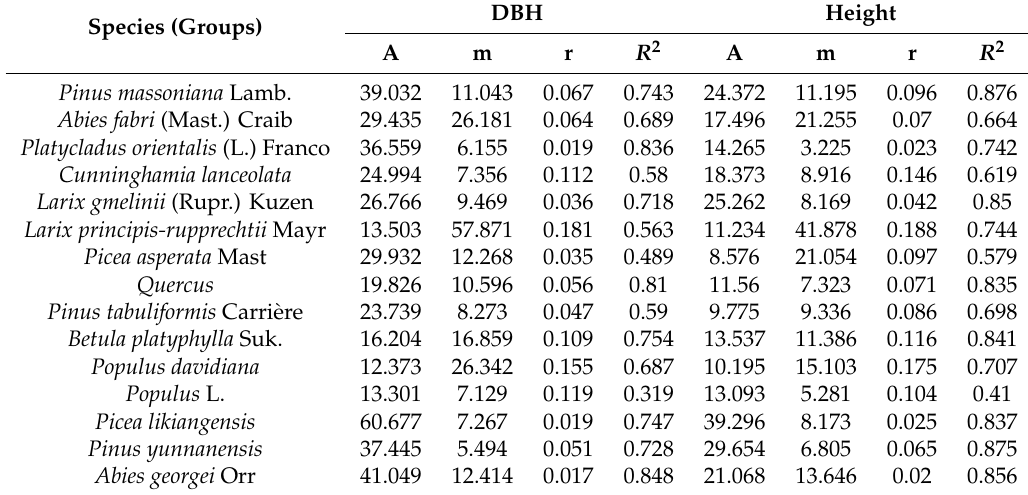
Table A5. Fitting results for the Logistic (1983) equation for di ff erent species. Species (Groups)